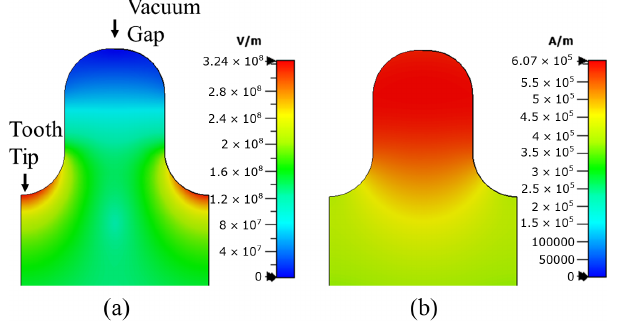
FIG. 8. Peak electric field distribution (a) and magnetic field distribution (b) of the 90 MV m − 1 TM 01 accelerating mode in the A-STAR corrugated